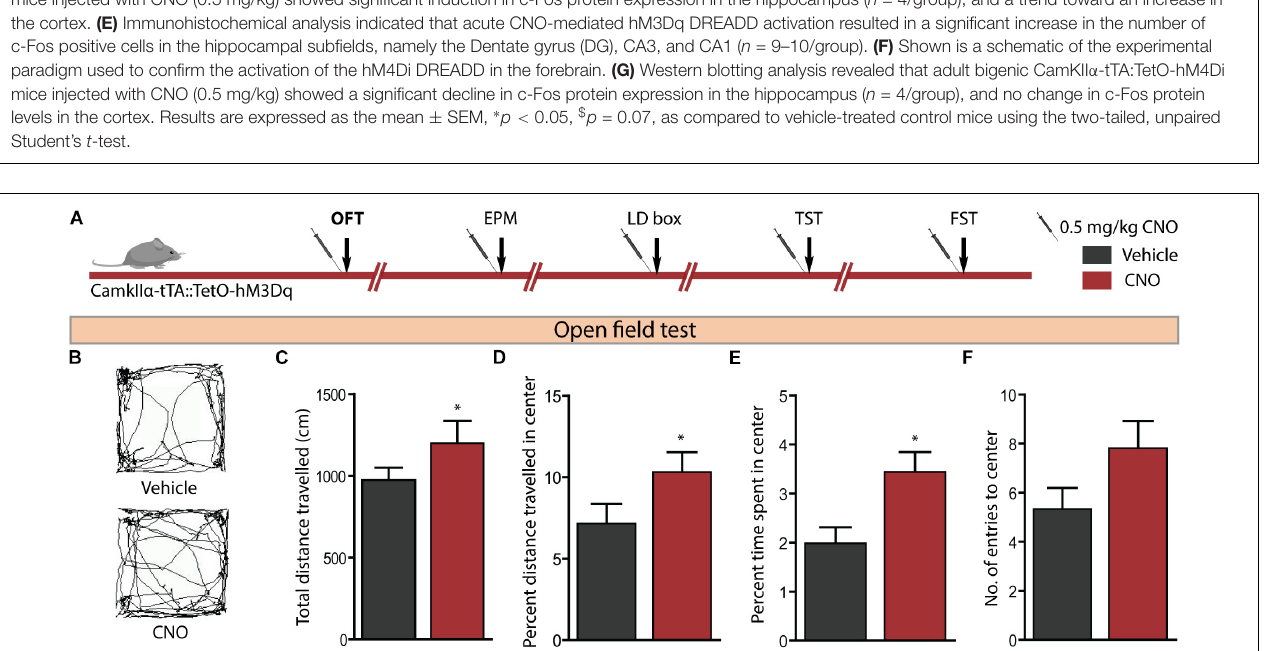
FIGURE 2 | Acute CNO-mediated DREADD activation of CamKII α -positive forebrain excitatory neurons reduces anxiety-like behaviour on the open field test (OFT). (A) Shown is a schematic of the experimental paradigm used to determine the influence of acute CNO (0.5 mg/kg)-mediated hM3Dq activation of CamKII α -positive forebrain excitatory neurons in adult male bigenic CamKII α -tTA:TetO-hM3Dq mice on anxiety and despair-like behaviour. Treatment groups were subjected to a battery of anxiety and despair-like behavioural tasks, with an interim washout period of 7–10 days ( n = 9–10/group). Shown in this figure is the anxiety-like behaviour on the OFT (B–F) following acute hM3Dq DREADD activation of forebrain excitatory neurons, commencing 30 min following CNO administration. (B) Shown are representative tracks from a vehicle and CNO treated CamKII α -tTA:TetO-hM3Dq mouse in the OFT. CNO-mediated hM3Dq DREADD activation of CamKII α -positive forebrain excitatory neurons resulted in decline in anxiety-like behaviour on the OFT as revealed by significant increases in the total distance travelled (C) , percent distance travelled in the centre (D) , and percent time spent in the centre (E) of the OFT arena as compared to the vehicle-treated group. No significant difference was observed in the number of entries made to the centre of the arena (F) . Results are expressed as the mean ± SEM ( n = 9–10/group), ∗ p < 0.05, as compared to vehicle-treated CamKII α -tTA:TetO-hM3Dq mice, two-tailed, unpaired Student’s t -test. EPM, elevated plus maze test; LD, light–dark avoidance test; TST, tail suspension test; FST, forced swim